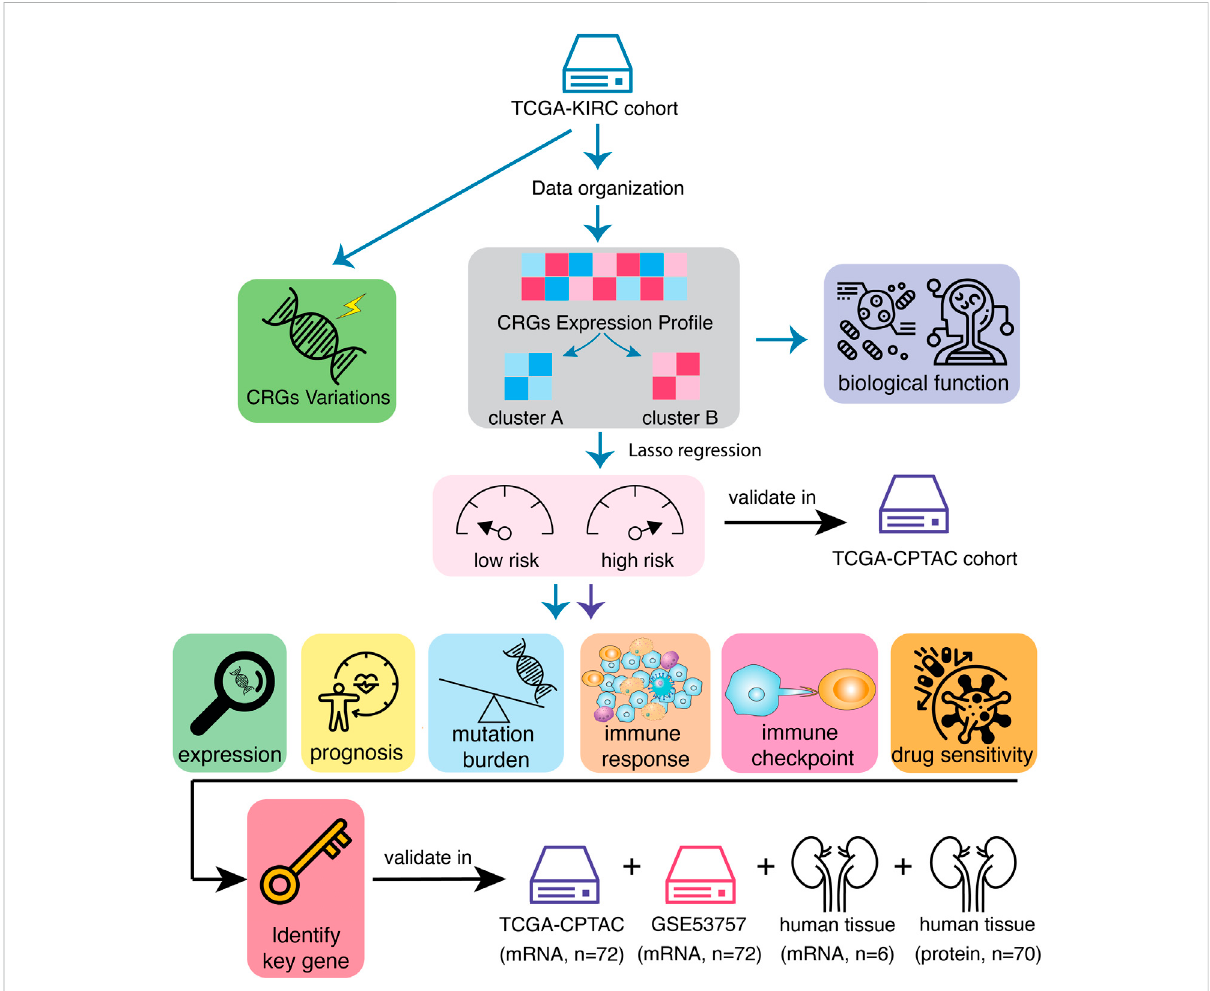
FIGURE 1 Work fl owofdataanalysisinthestudy.Data of541samplesfromTCGA-KIRC cohorthavebeen organized andthevariationsofcalcium-related genes (CRGs) have been explored. Then, KIRC patients have been divided into two clusters according to CRGs expression pro fi le. The differences of prognosis and biological functions have been investigated based on CRG clusters. In order to screen the most prognostic-related genes, univariate CoxregressionandLASSOanalysiswereperformedandtheKIRCpatientshavebeendividedintoCRGs-relatedhigh-riskandlow-risksubtypes. These results have been validated in another mRNA cohort, TCGA-CPTAC. Immune landscapes, including tumor mutation burden, immune cell in fi ltration, immune checkpoint expression as well as the sensitivity of immunotherapies, have been tested in distinct risk subtypes. Finally, key CRG that most associated with prognosis in KIRC tumors has been identi fi ed and